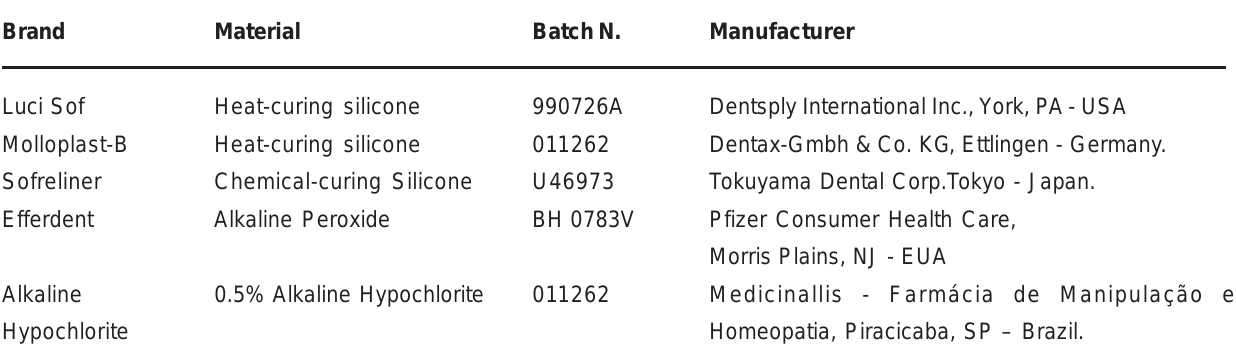
TABLE 1- Resilient denture liners and denture cleansers